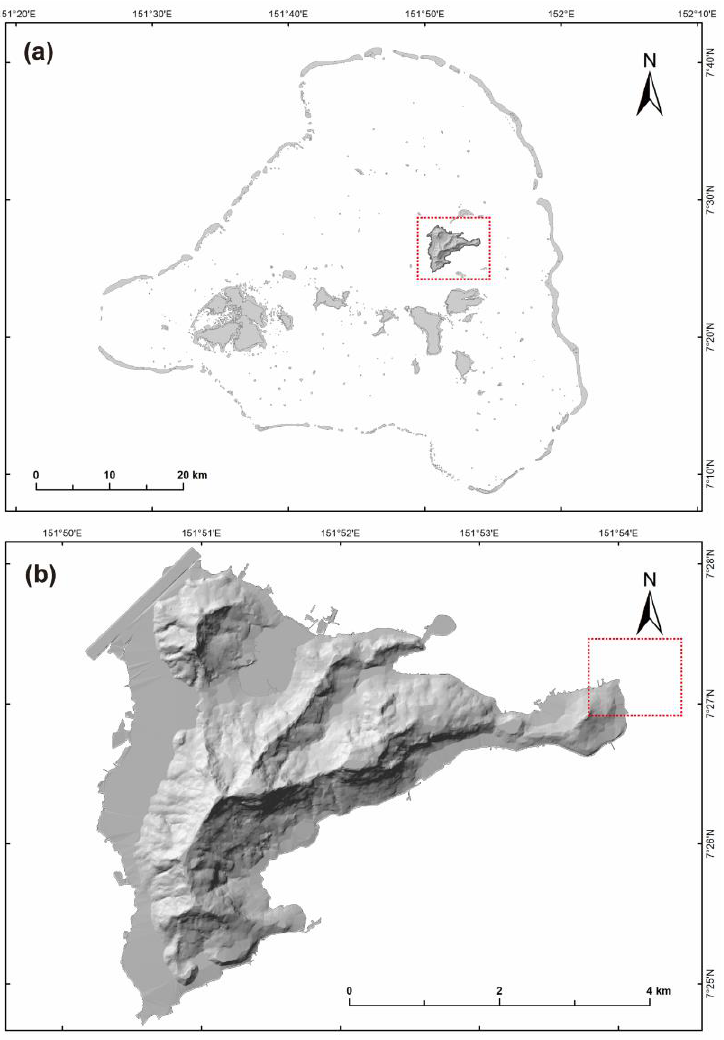
Figure 1. Location map. ( a ) Chuuk Atoll of the Federated States of Micronesia. Red dotted square marks Weno Island. ( b ) Weno Island within the Chuuk Atoll. Red dotted square marks study site.